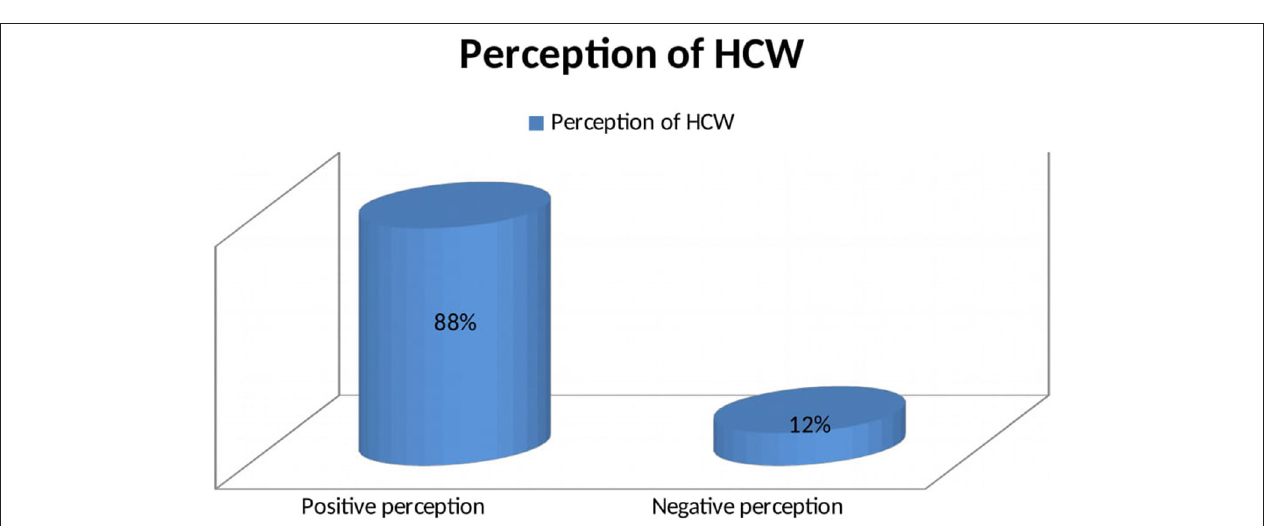
FIGURE 2 | Perception of COVID-19 among health workers at Aksum University Comprehensive and Specialized Hospital (AKUCSH) and Sain’t Marry’s General Hospital in Tigray Regional State of Northern